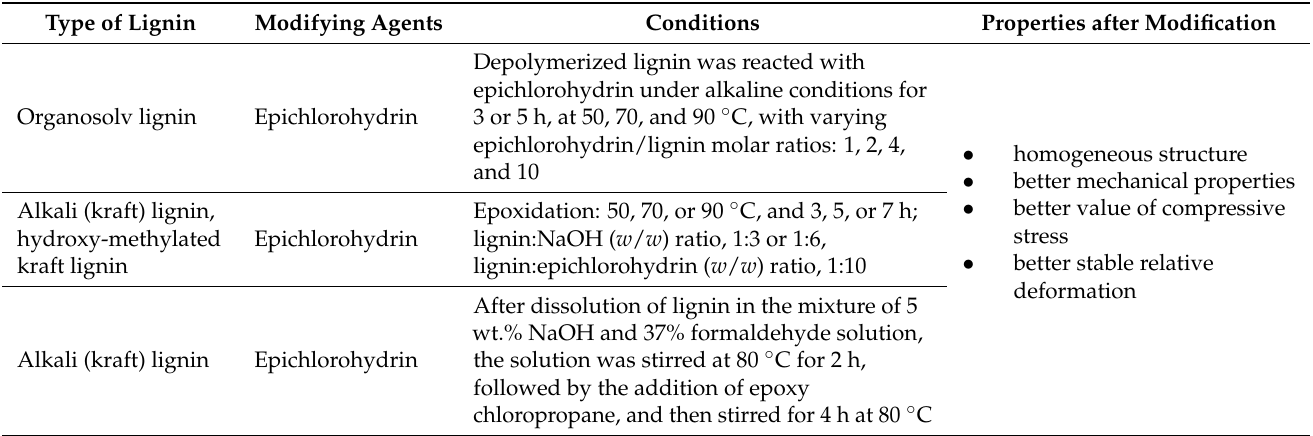
Figure 6. ( A – D ) SEM micrographs of epoxy composites at different magnification: ( A , C ) = Amine- cured EFB/epoxy composite — EPAC. ( B , D ) = Typical lignin-cured EFB/epoxy composite — EP-L20. The arrows indicate the pores on the fracture surface. Reproduced from [97], with the permission of Elsevier. Table 7. Table summarizing the epoxidation process of lignin.